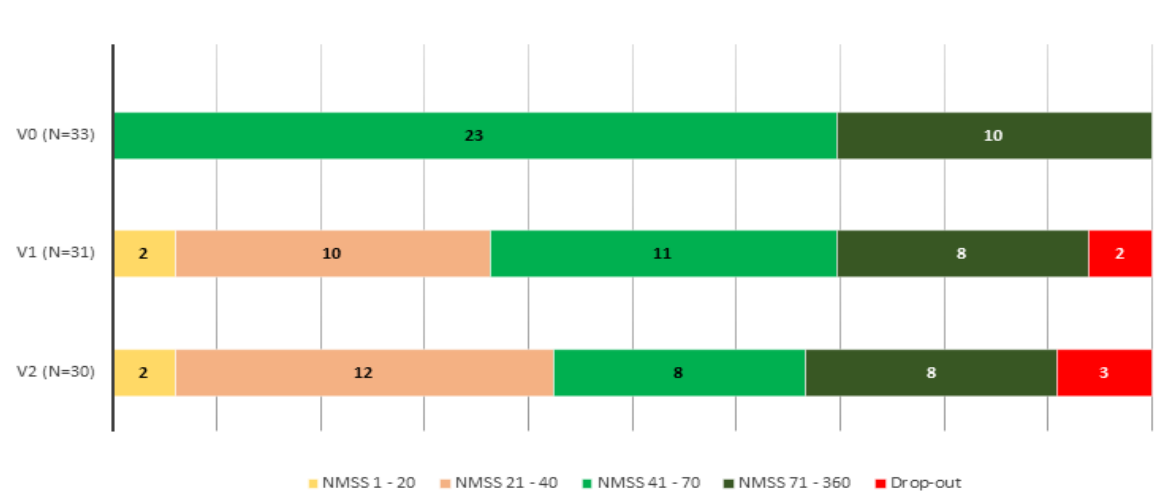
(Sleep/fatigue) ( p < 0.0001), NMSS-3 (Mood/apathy) ( p < 0.001), NMSS-6 (Gastrointestinal symptoms) ( p = 0.029), and NMSS-9 (Miscellaneous) ( p = 0.021). ( B ). Mean score on each domain of the PDQ-39SI at V0, V1, and V2. The difference between V2 and V0 was significant for PDQ-39SI-3 (Emotional well-being) ( p = 0.004), PDQ-39SI-4 (Stigmatization) ( p = 0.009), and PDQ-39SI-8 (Pain and discomfort) ( p = 0.023). p values were computed using the Wilcoxon signed-rank test.